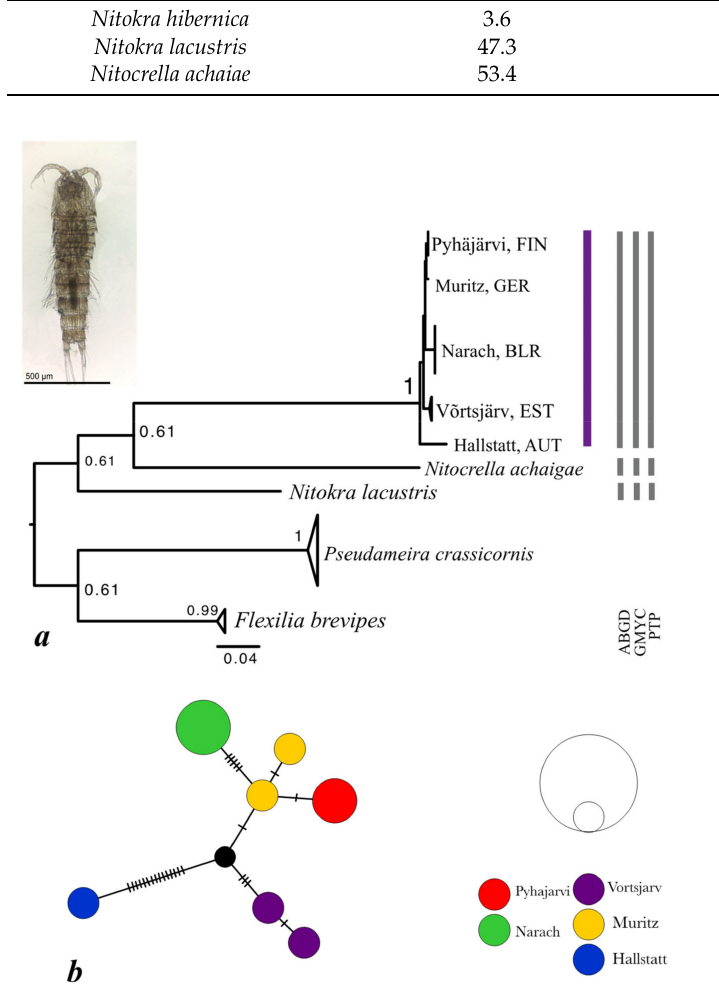
Figure 4. Maximim likelihood tree based on sequences of mitochondrial cytochrome oxidase subunit I (COI) mtDNA gene of Nitokra hibernica and related species ( a ). Numbers at the nodes are bootstrap values. As an outgroup, sequences of Flexilia brevipes (accession numbers MH976594-MH976596) and Pseudoameira crassicornis (MK037002, MK037019, MK036966) were used. ( b ) Median-joining network of COI haplotypes from Nitokra hibernica . Black dot indicates a median vector (ancestral, unsampled, or extinct haplotype). Black hatch marks denote the number of mutational steps between haplotypes. Circles are proportional to the haplotype